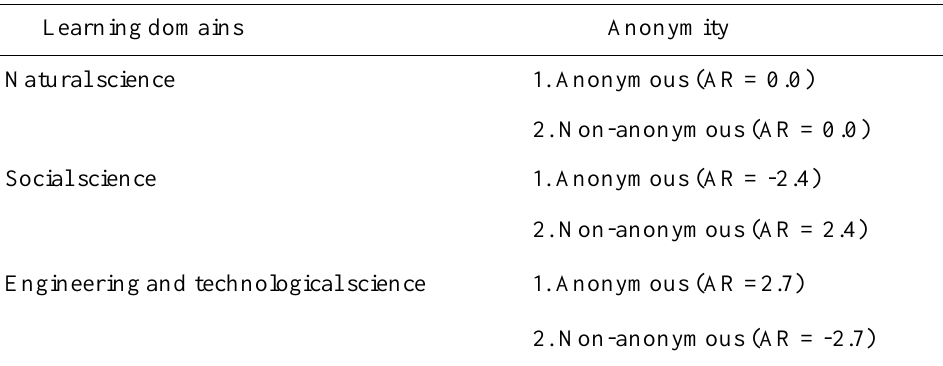
The Relationships Between Learning Domains and Anonymity Learning domains